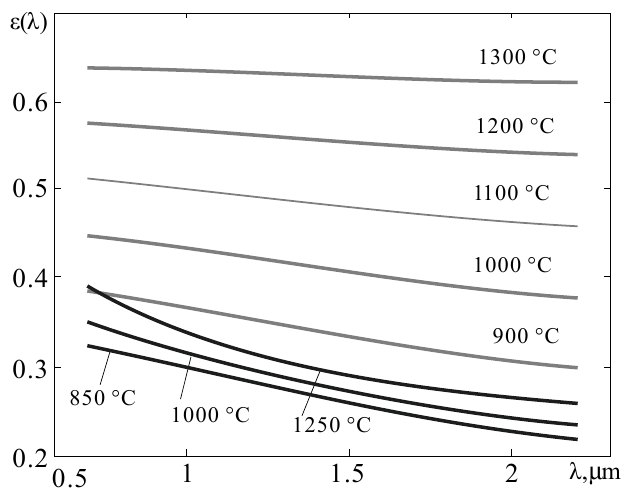
Figure 8. Changes in the ε ( λ ) dependence of pure iron when it is heated in vacuum [18] (black lines) and during gradual oxidation with atmospheric oxygen (gray lines).